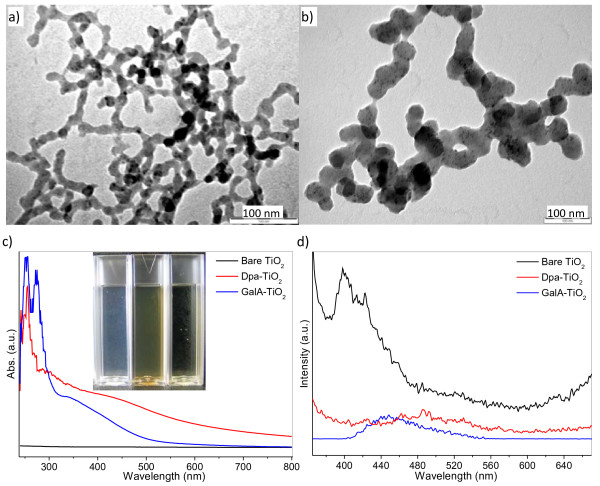
TEM images, UV–vis absorbance spectra, and PL emission spectra of TiO2NPs. TEM images of as-synthesized GalA-TiO2 NPs (a) and Dpa-TiO2 NPs (b). UV–vis absorbance spectra (c) and their photos (inset: from left to right: bare, Dpa- and GalA-TiO2 NP aqueous solutions). PL emission spectra (λex. = 350 nm) (d) of the NP aqueous dispersions.